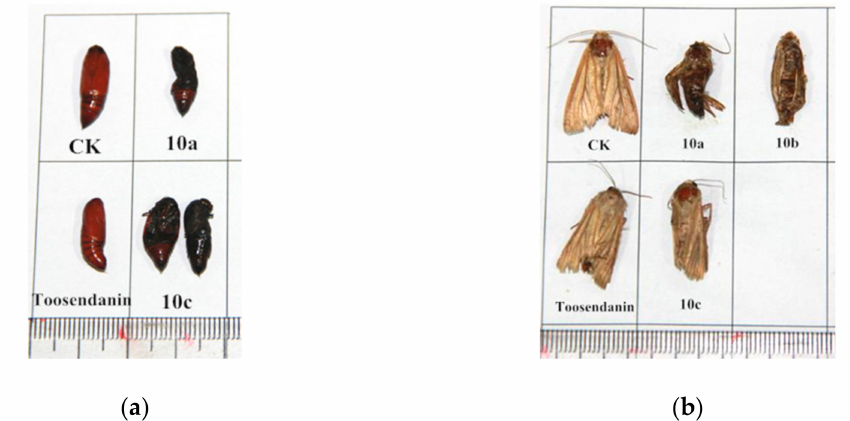
Figure 3. Representative malformed pictures: ( a ) Malformed pupae of 3a (10a) and 3c (10c) during the pupation period; ( b ) malformed moth of 3a (10a), 3b (10b) and 3c (10c) during the stage of adult emergence (CK = blank control group, toosendanin = positive control